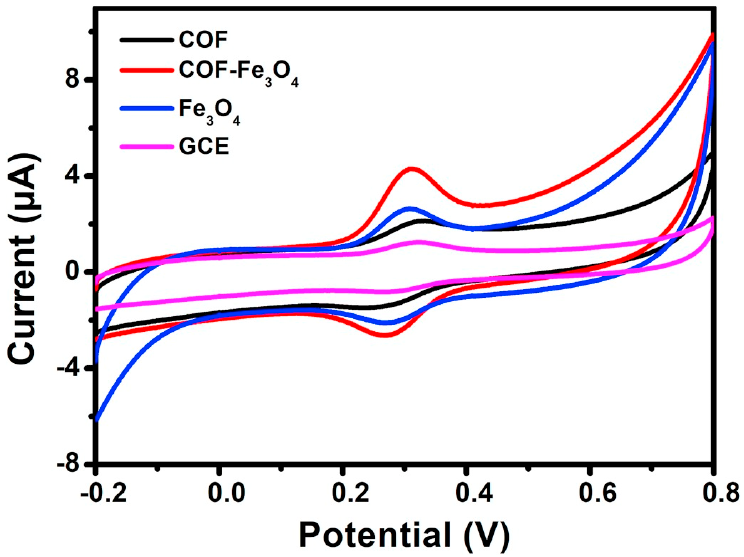
Figure 3. Cyclic voltammograms of Fe 3 O 4 @TAPB-DMTP-COFs/GCE, bare GCE, TAPB-DMTP- COFs/GCE, and Fe 3 O 4 /GCE from Ref. [68]. Copyright 2020 Elsevier.